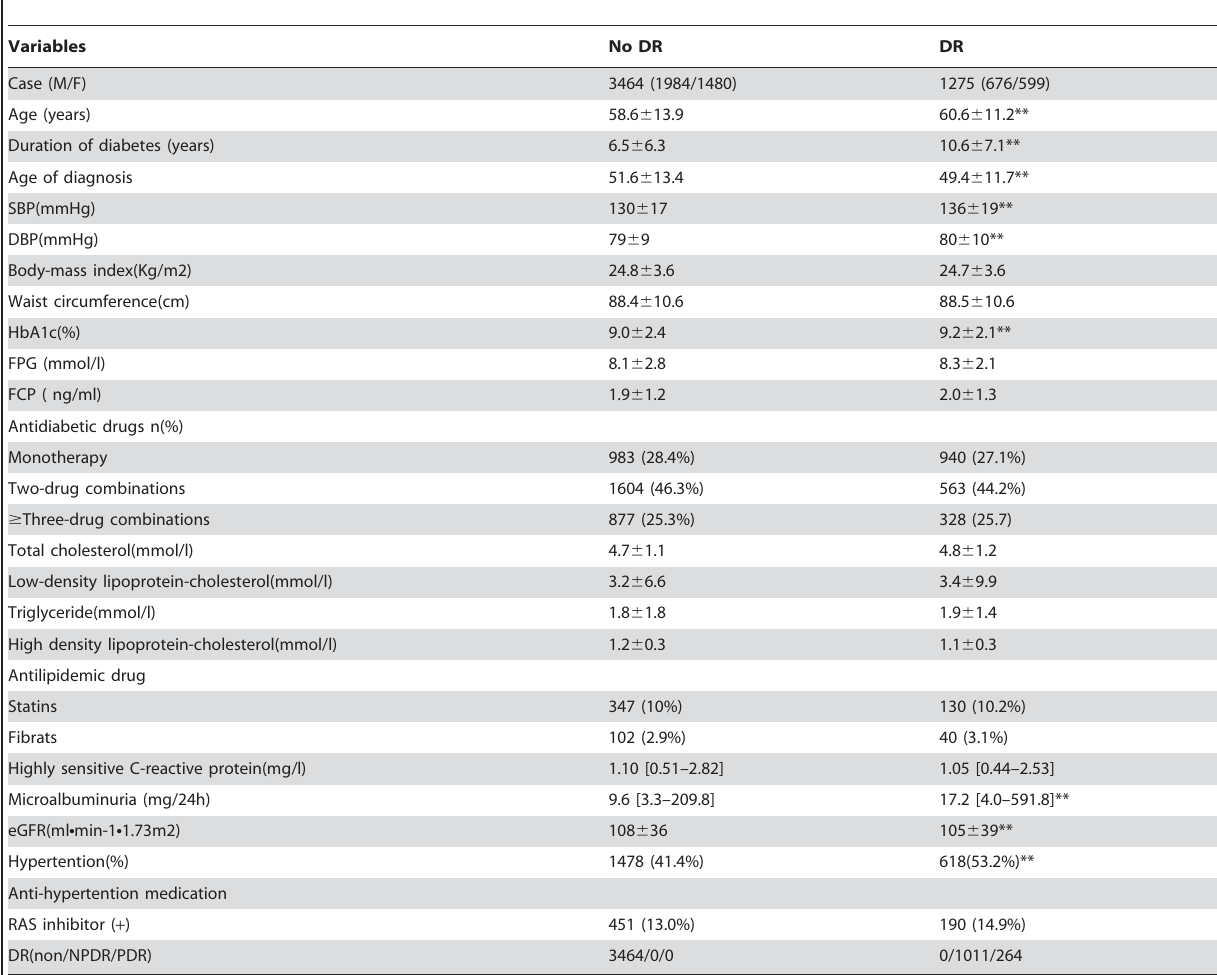
Table 1. Clinical characteristics of type 2 diabetes mellitus patients without or with